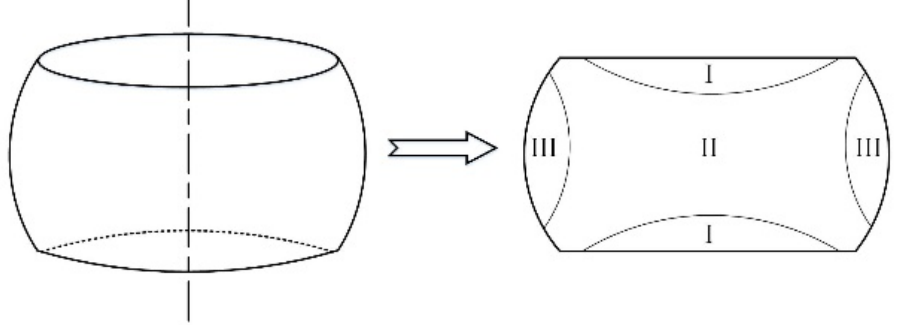
Figure 7. Schematic of difficult (I), large (II) and small (III) deformation areas of the specimen after upsetting.